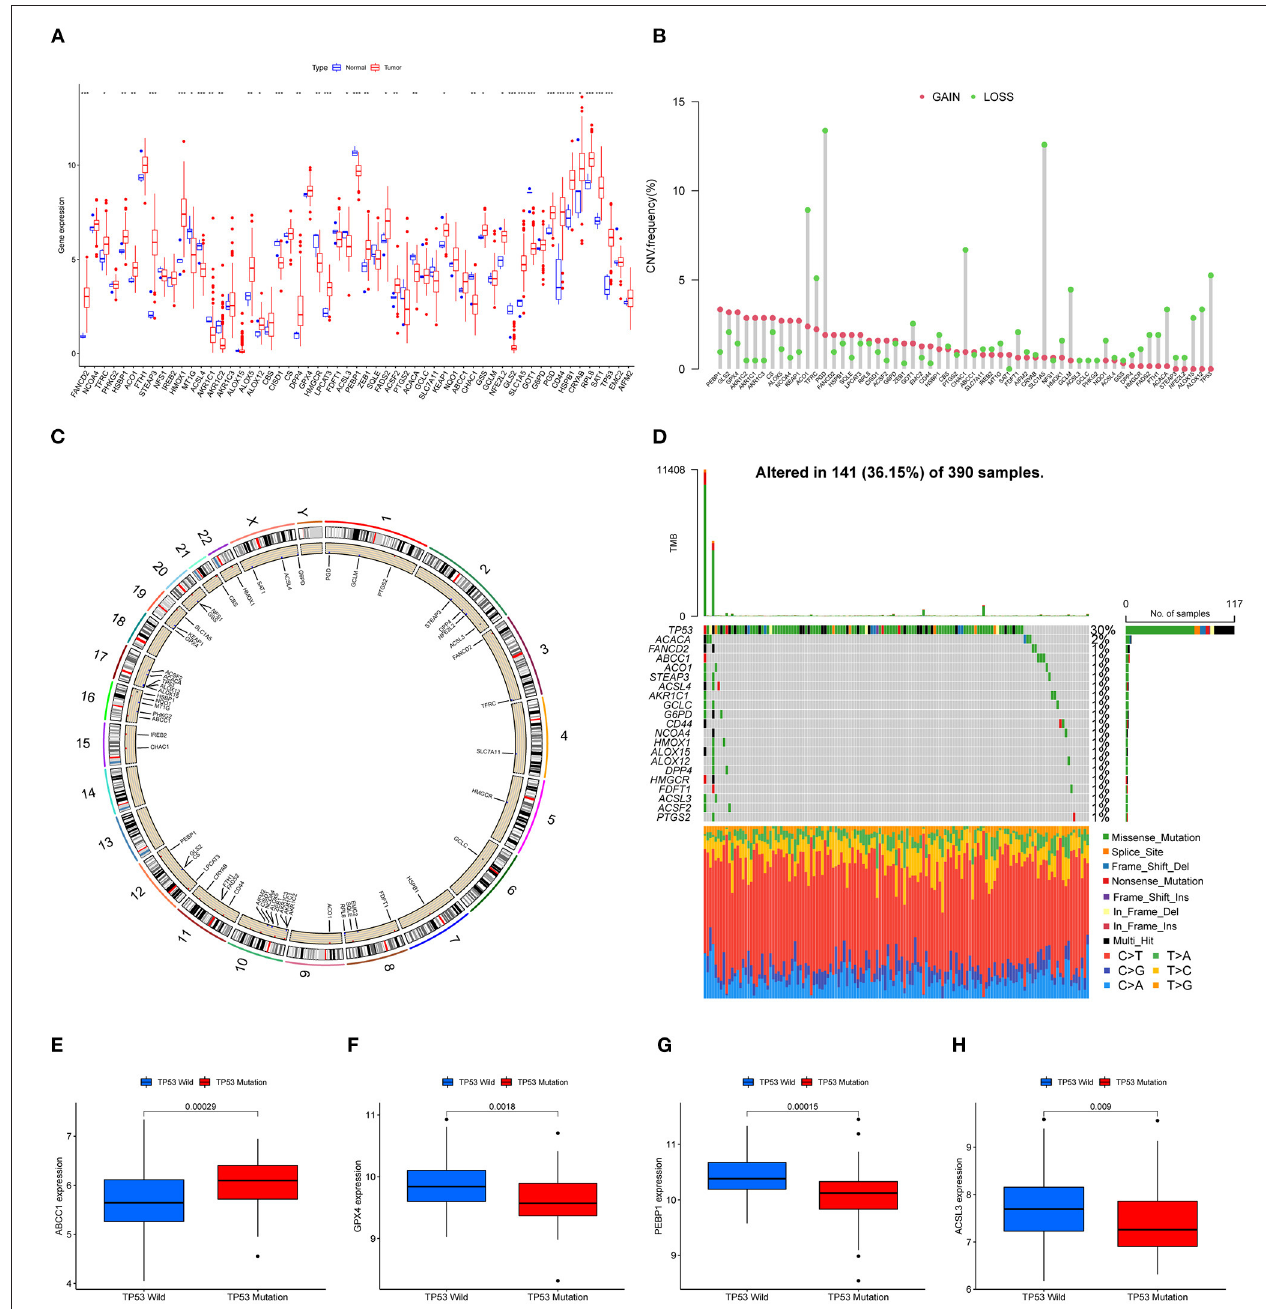
FIGURE 1 | Landscape of FRGs in TCGA-GBM. (A) The expression levels of FRGs in the TCGA dataset. Red: upregulated genes; blue: downregulated genes. (B) CNV frequency; red: CNV gain; green: CNV loss. (C) The CNV distribution of all chromosomes. (D) The mutation of FRGs in GBM; green boxes represent missense mutations, orange splicing mutations, blue frameshift mutations, and red nonsense mutations. (E–H) Four genes (ABCC1, GPX4, PEBP1, and ACSL3) with significantly different expressions between TP53 wildtype and mutant ( p <